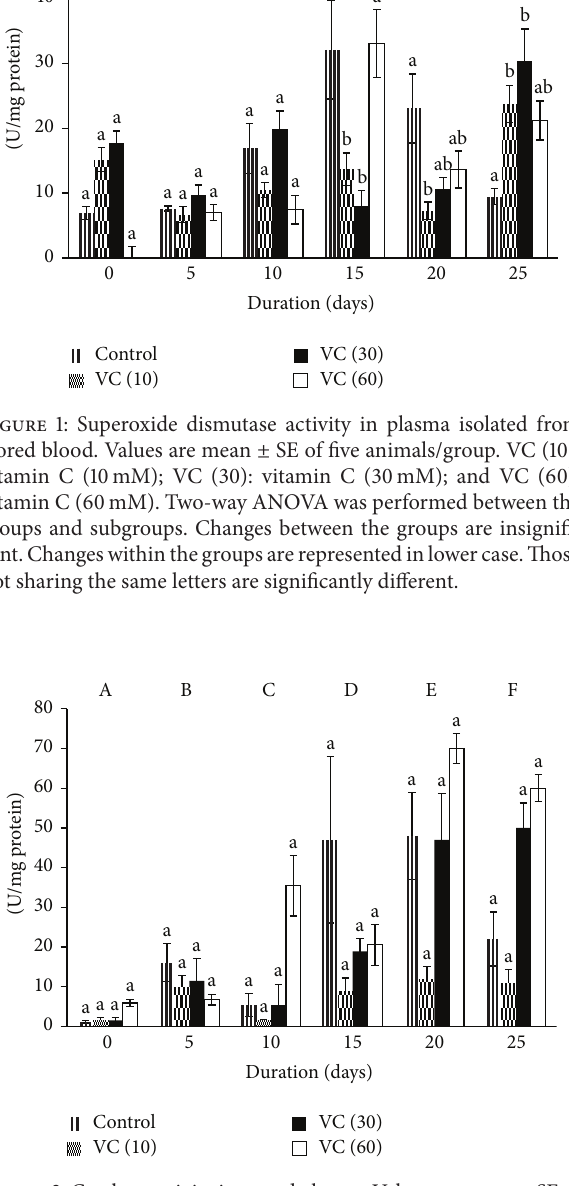
Figure 2: Catalase activity in stored plasma. Values are mean ± SE of five animals/group. VC (10): vitamin C (10mM), VC (30): vitamin C (30 mM), and VC (60): vitamin C (60mM). Two-way ANOVA was performed between the groups and subgroups. A–F values between the groups are significantly different at 𝑃 < 0 . 05. Changes within the groups are represented in lower case. Those not sharing the same letters are significantly